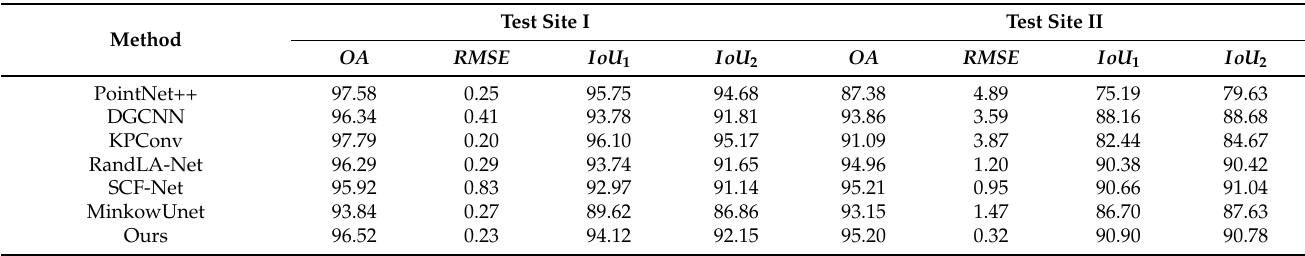
Table 3. Comparison with the baseline methods of